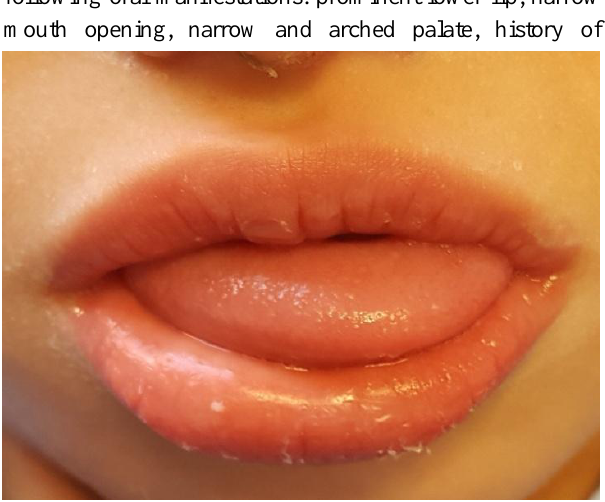
Figure 3 : Macroglossia and lingual interposition in the anterior